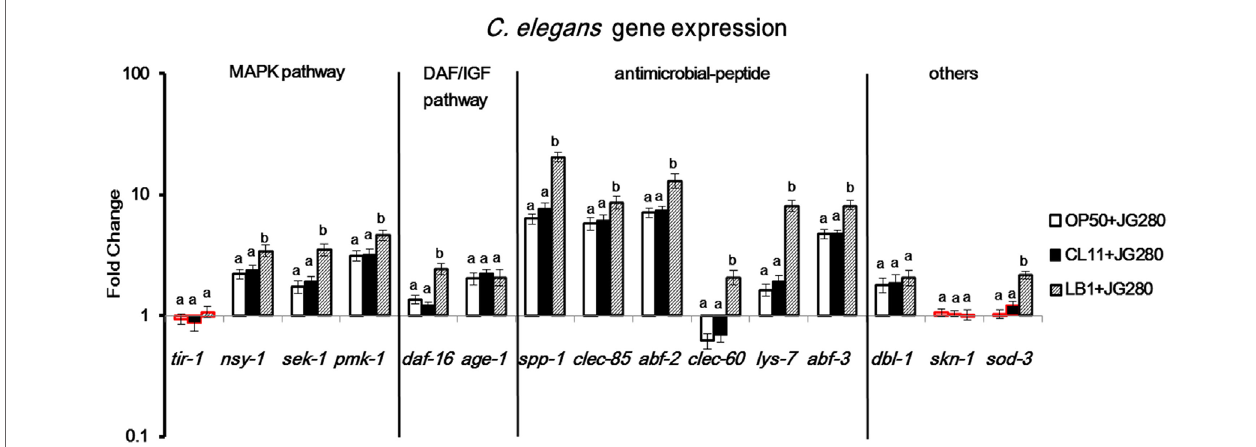
FigUre 2 | Gene expression of the wild-type Caenorhabditis elegans in response to the treatment of Enterotoxigenic Escherichia coli (ETEC) JG280 only, or to ETEC JG280 after pretreatment with Lactobacillus zeae LB1 or L. casei CL11. The nematode was sampled on day 2 of the life-span assays. The baseline is the level of gene expression in C. elegans treated with E. coli OP50 only. Relative expression was determined using the 2 −ΔΔ Ct method as the ratio of transcript level of each target gene to the housekeeping genes within each group and expressed as fold changes by comparing each treatment group to the control group ( E. coli OP50). The first Δ CT is the comparison between target genes and housekeeping genes. The second Δ CT represents the comparison between treatment group and control group. Data are presented as mean ± SD. Means marked with “a,” “b” were significantly different ( P ≤ 0.05) for the same gene among different treatments. While the treatment groups represented by the bars with their borders in red had no significant difference ( P > 0.05) between each treatment and the control group (fed E. coli OP50 only) in the gene expression level of the same gene, the remaining treatment groups represented by the bars with their borders in black differed significantly from the control group ( P ≤